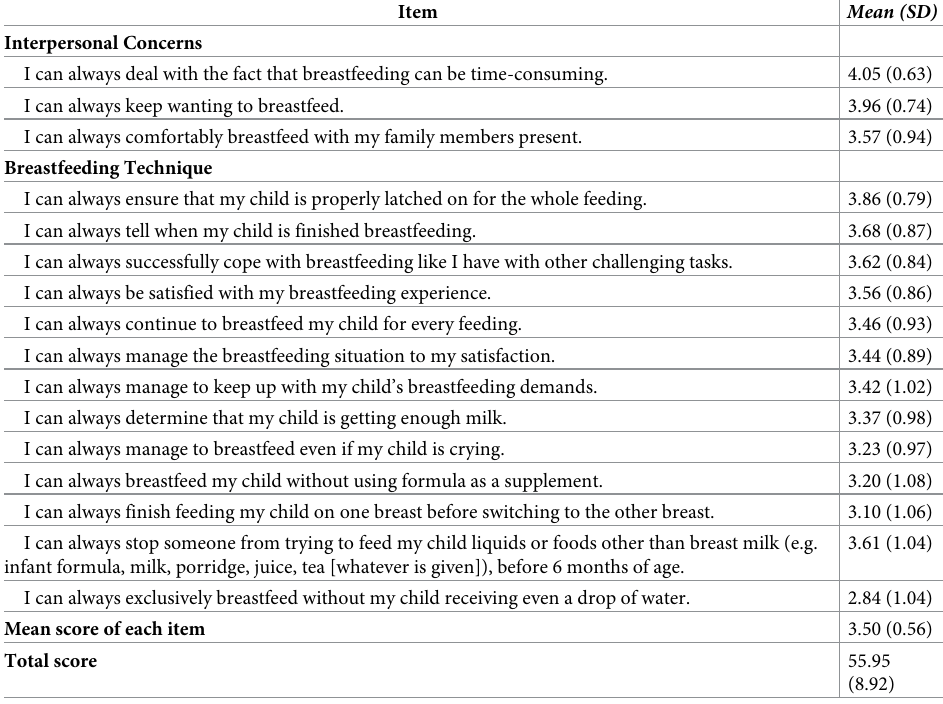
Table 2. Participant responses to the Breastfeeding Self-Efficacy scale (N = 787). Item Mean (SD) Interpersonal